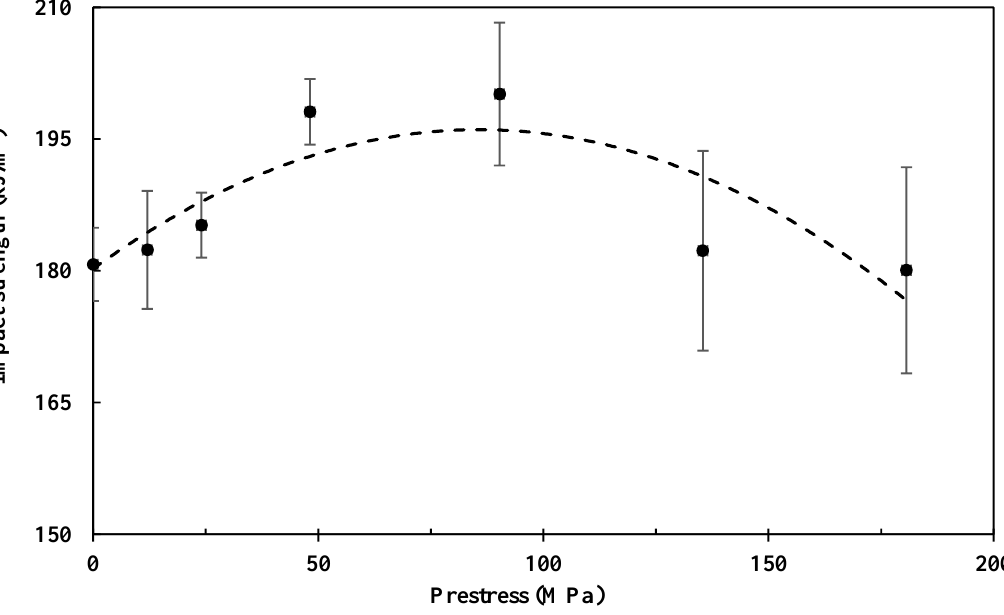
Figure 7. Effects of fibre prestressing level on impact strength of the composite. Each prestress level was tested six times for repeatability, and standard errors are presented by the error bars.